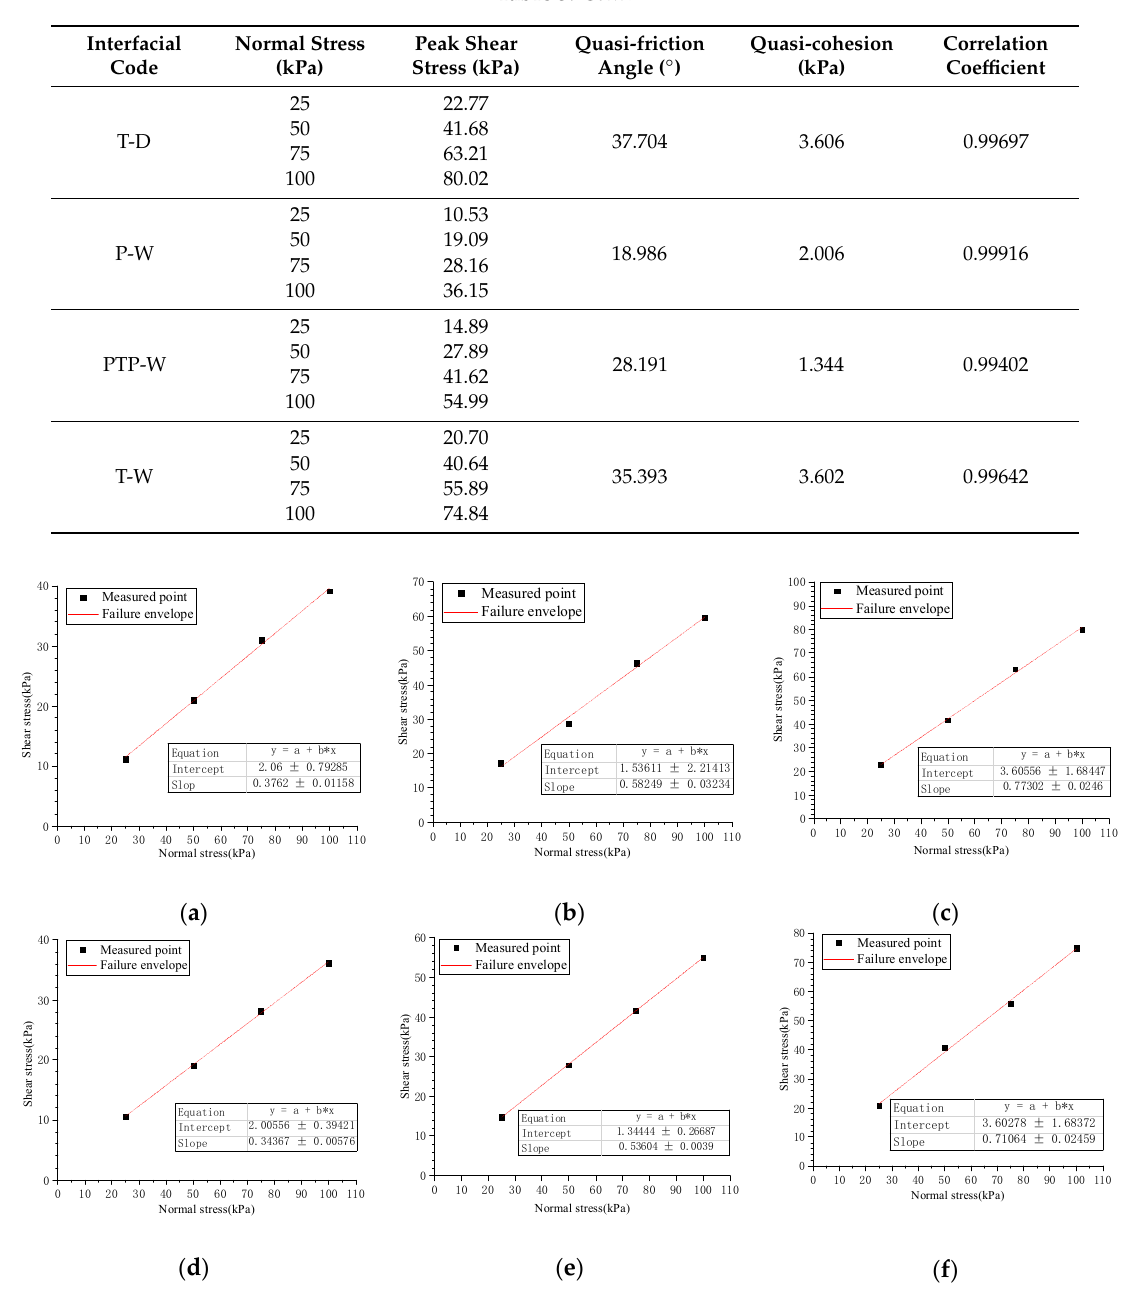
Figure 9. Failure envelopes of shear strengths of different interfaces. ( a ) Failure envelope of shear strength on P-D interface. ( b ) Failure envelope of shear strength on PTP-D interface. ( c ) Failure envelope of shear strength on T-D interface. ( d ) Failure envelope of shear strength on P-W interface. ( e ) Failure envelope of shear strength on PTP-W interface. ( f ) Failure envelope of shear strength on T-W interface.